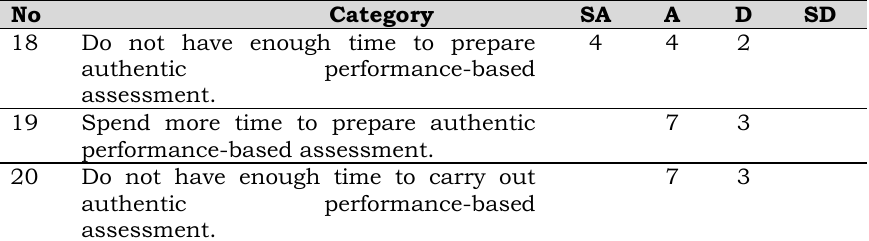
Washback Effect on Time